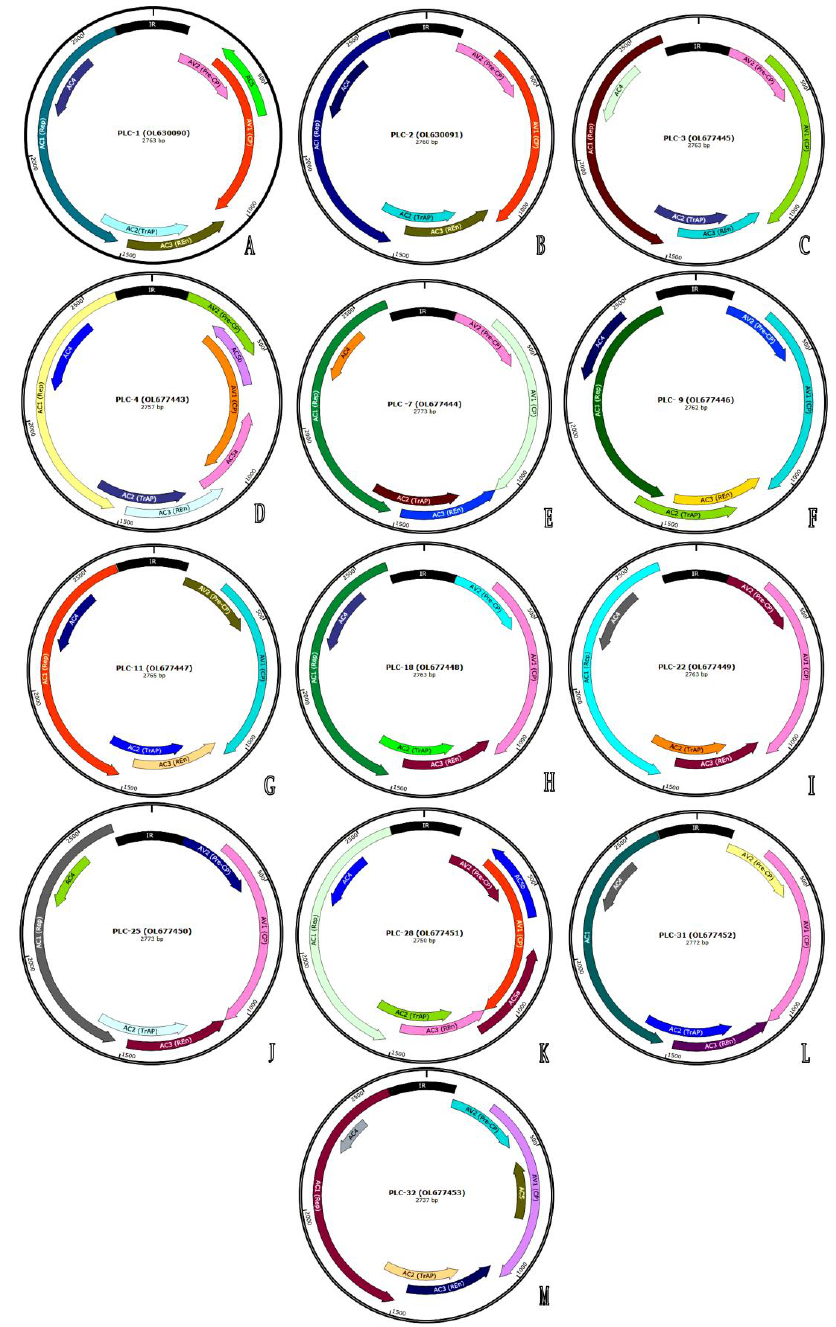
Figure 2. Genome organization structure of DNA-A component of begomoviruses isolated from pa- paya. ( A ). PLC-1:OL630090; ( B ). PLC-2:OL630091; ( C ). PLC-3:OL677445; ( D ).